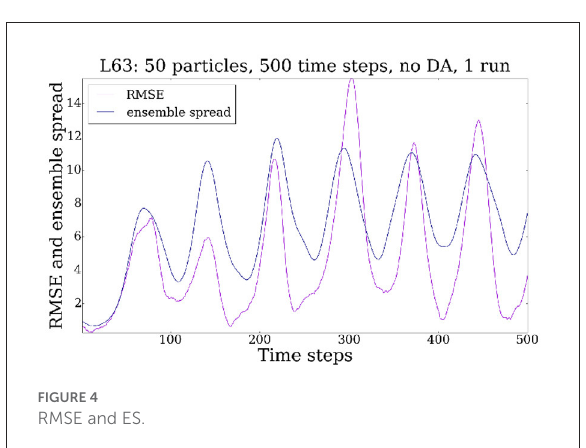
FIGURE4 RMSE and ES.